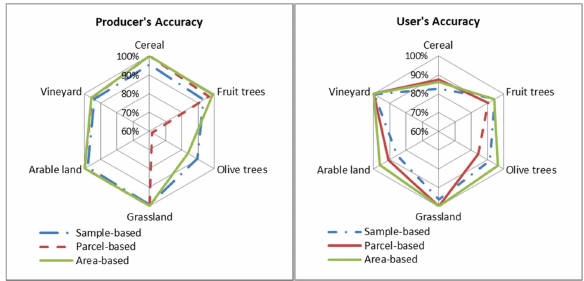
Figure 6. Comparison, in terms of producer’s and user’s accuracies, of the three types of evaluation performed at sample, parcel and area levels for crop classification using the described CNN. Table 3. Results in the identification of abandoned crops. Only abandoned parcels from classes vineyards , fruit trees and olive trees were used. (OvAcc: Overall Accuracy; PrAcc: Producer’s Accuracy; UsAcc: User’s